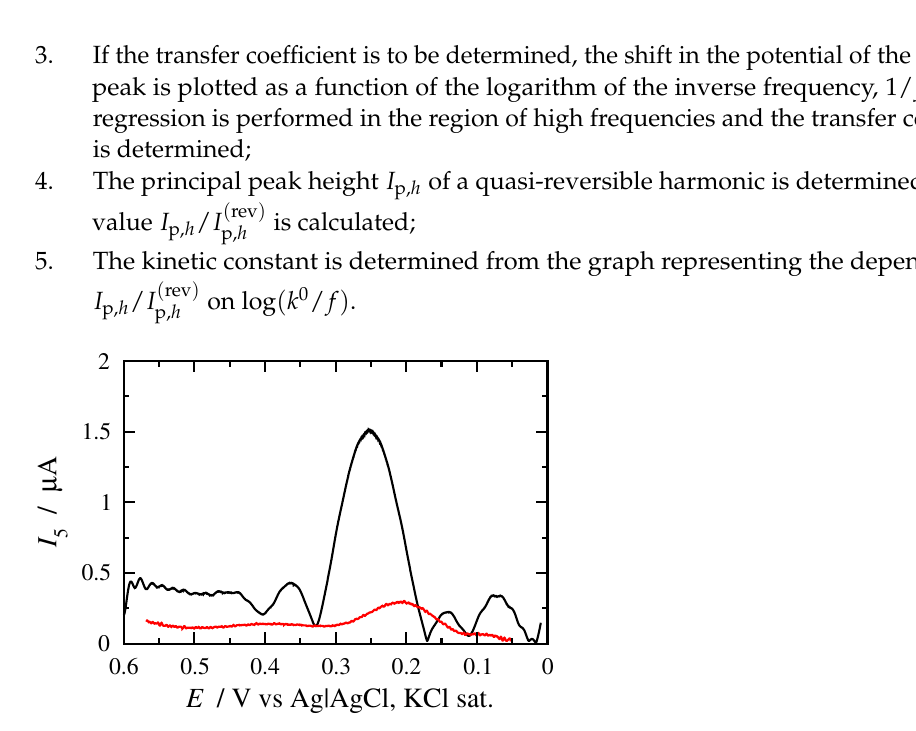
Figure 3. Experimental results: 5th harmonics of Mt LPMO9Himmobilised on a Co-f-MWCNTs modified GC electrode (black) and Co-f-MWCNTs modified GC electrode without the enzyme (red) at 25 ◦ C. Experimental conditions: acetate buffer 500 mM, pH 6, A 0 = 0.20 V and f =